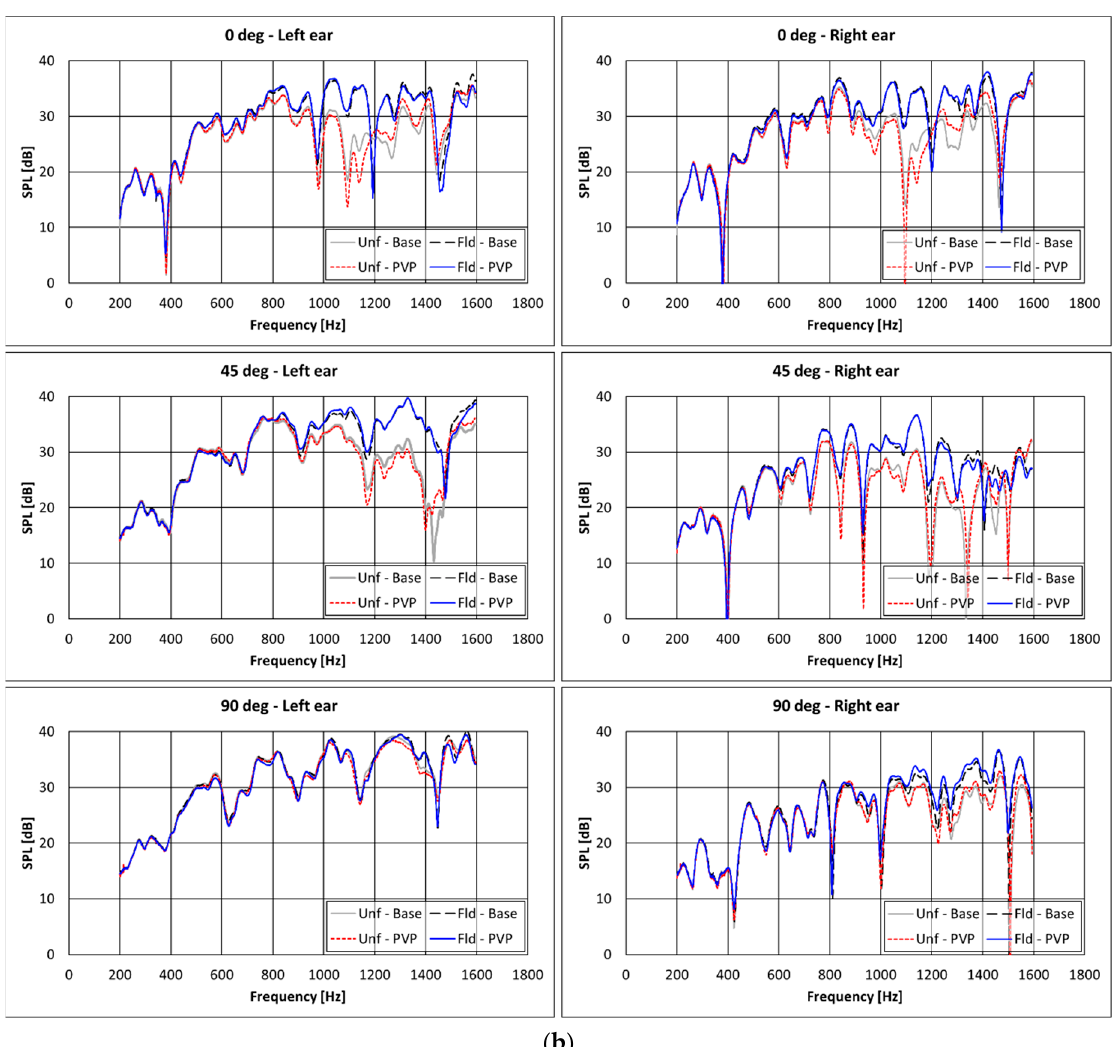
Figure 11. Experimental results in terms of SPL vs. frequency spectra for different headrest’s configurations; monopole source at a distance equal to ( a ) 75 cm or ( b ) 150 cm; “PVP” or “Base” refer to the configurations with or without the PVP + silica nanofibrous insertions in the caps.